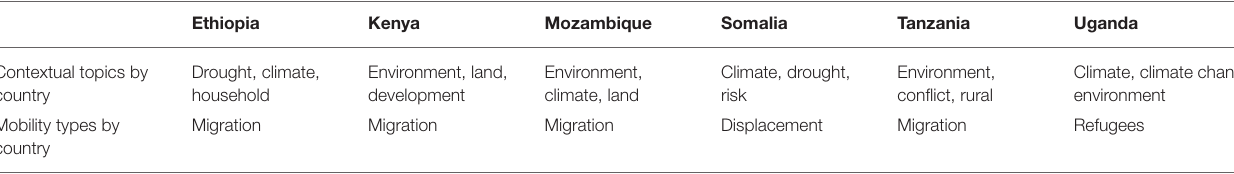
TABLE 1 | Topic map showing the distribution of mobility types and contextual factors across countries.